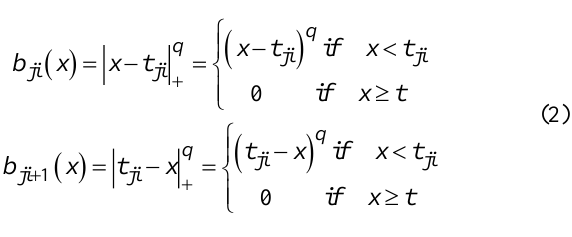
represents the spline power and the degree of smoothness of the resultant function approximation. The determination of the basis function to be included in the model is done by generalized cross-validation (GCV) which is the mean of the squared residual error divided by a penalty